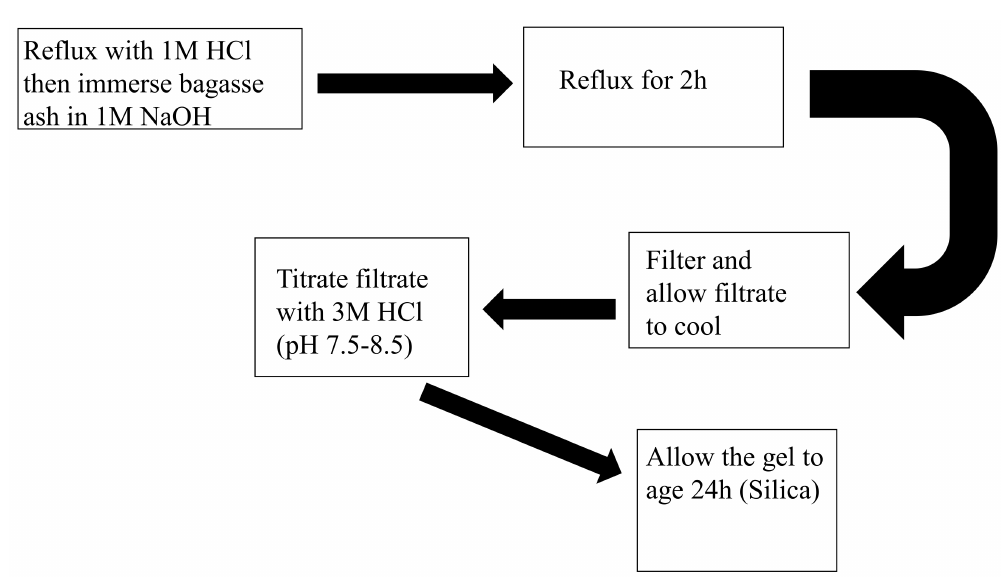
Figure 5. Sol gel method for silica